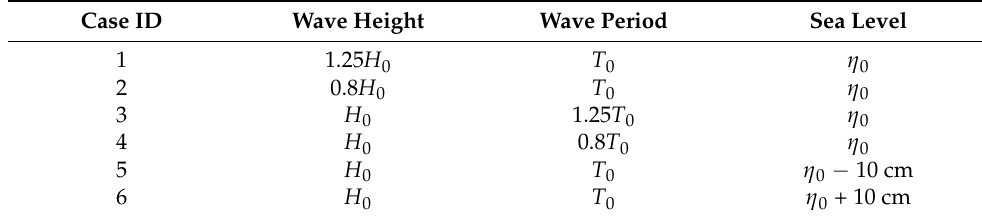
Table 1. Description of numerical cases.